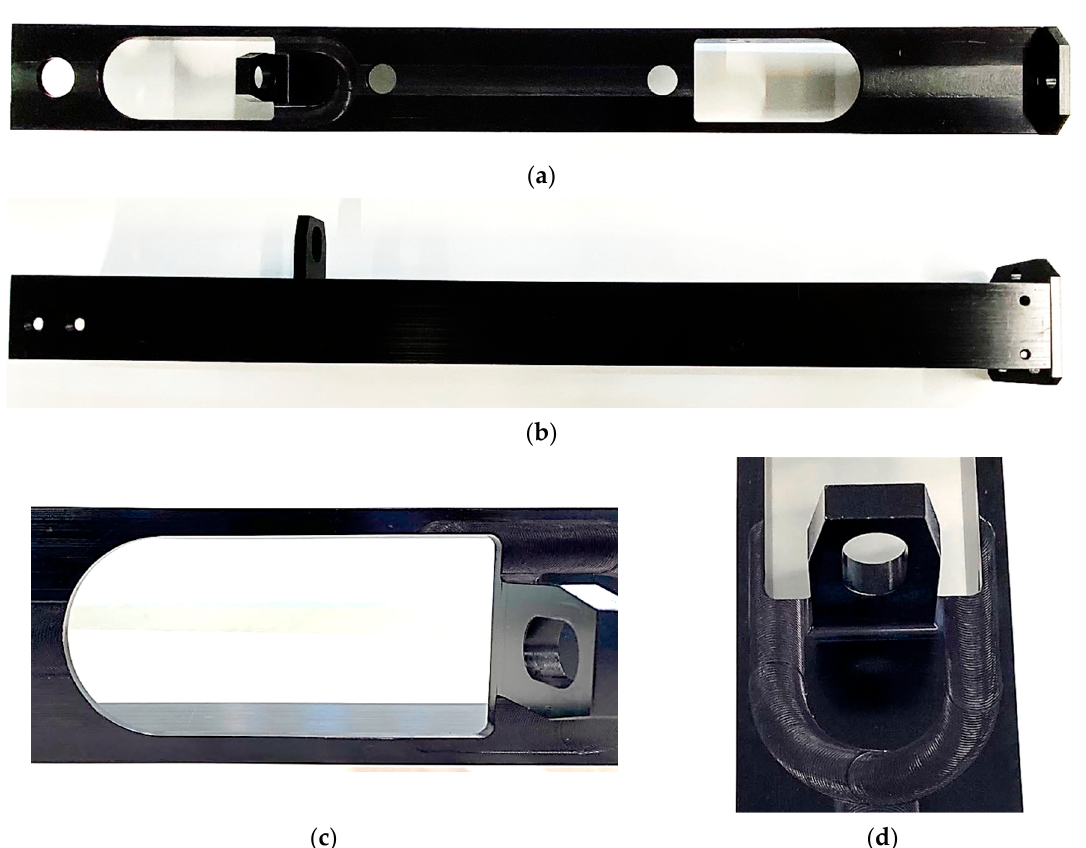
Figure 14. Final prototype images, ( a ) top view, ( b ) side view, ( c ) close-up of the bracket feature and ( d ) close-up picture of the bracket’s weld.